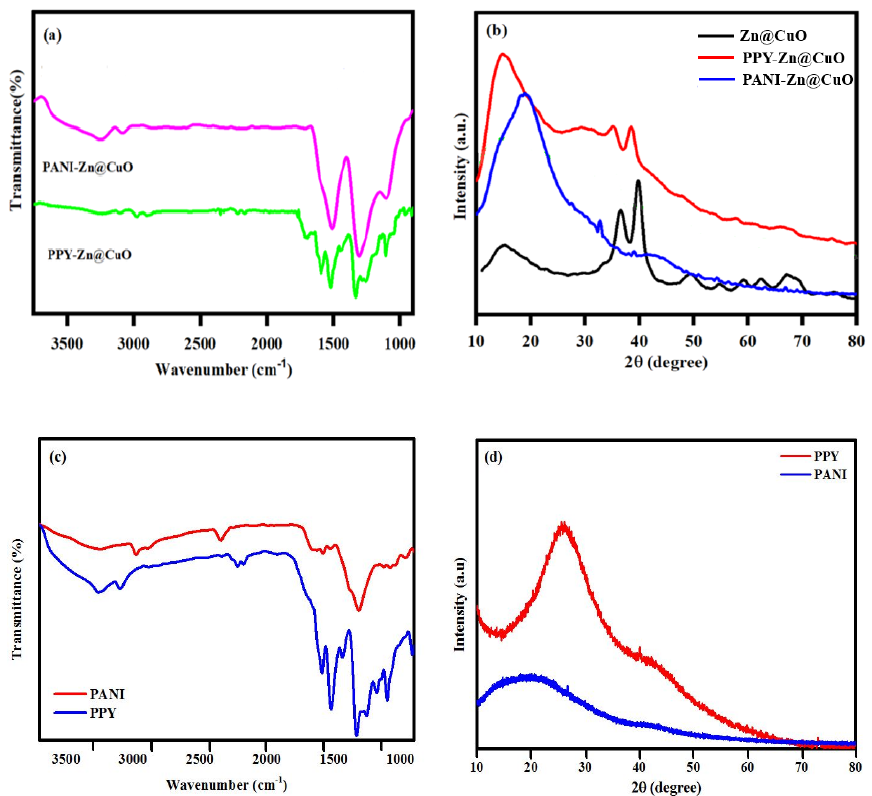
Figure 1. ( a , c ) FTIR spectrum and ( b , d ) XRD diffraction patterns of polymers and polymers’ macro-